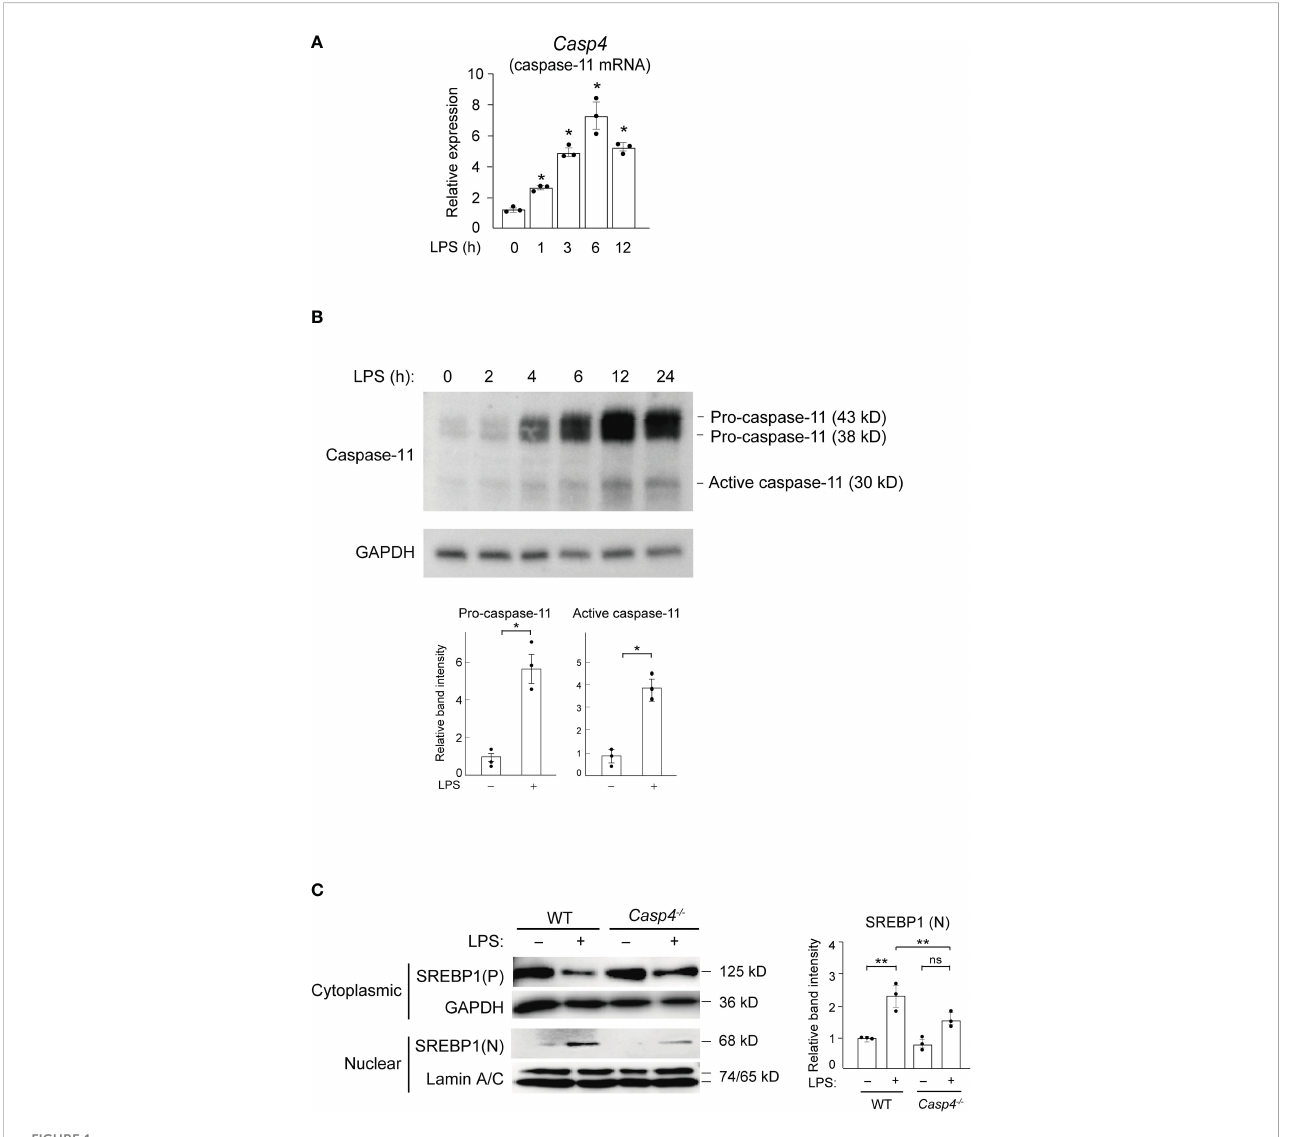
FIGURE 1 Caspase-11 is required for nuclear translocation of SREBP1 in response to LPS. (A, B) BMDMs were treated with 100 ng/ml LPS for the indicated times and subjected to quantitative RT-PCR (A) or western blot (B) analysis. In A, Casp4 mRNA expression levels were fi rst normalized to those of Gapdh and then to the level Casp4 expression at 0 h of LPS. Data represent means ± SEM. Signi fi cance was determined using one-way ANOVA followed by Tukey ’ s post hoc test versus 0 (h) * P < 0.05. n =3 for each time point. In B, whole cell lysates of LPS-treated BMDMs were subjected to western blotting for caspase-11 and GAPDH. The relative band intensities corresponding to pro-caspase-11 and active caspase-11 in untreated BMDMs and those treated with LPS for 6 h are shown in the bar graphs. n =3. Signi fi cance was determined using Student ’ s t -tests. * P < 0.05. (C) BMDMs from WT and Casp4 – / – mice were treated with LPS for 6 h, and cytoplasmic lysates and nuclear extracts were subjected to western blotting for SREBP1. A representative western blot of three independent experiments is shown. P, precursor; N, nuclear. The relative band intensities corresponding to nuclear SREBP1 are shown in the bar graph. n =3. Signi fi cance was determined using one-way ANOVA followed by Tukey ’ s test for multiple comparisons. ** P < 0.01; ns: not signi fi